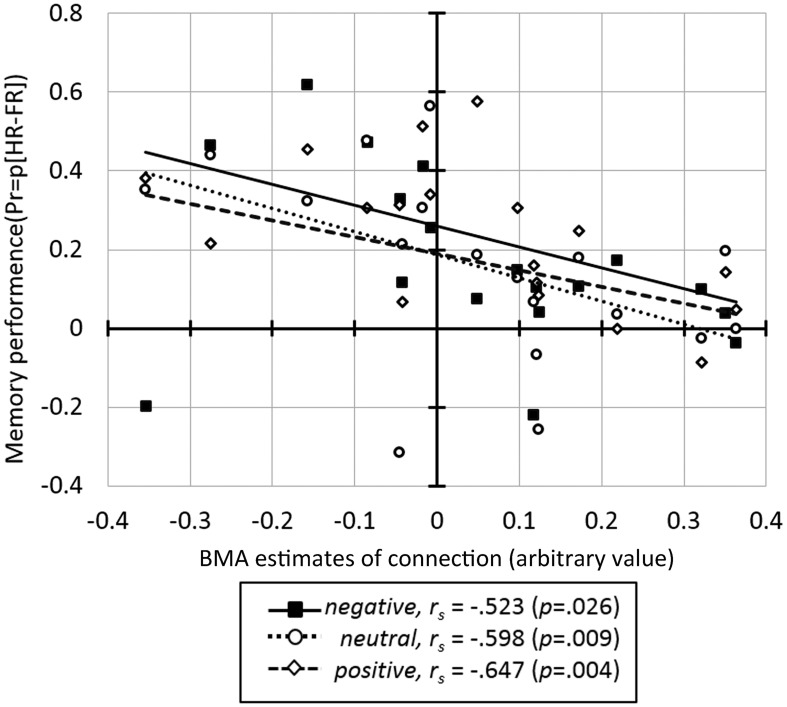
The correlation between the BMA parameter estimates for the IOG→OFC connection and memory performance for faces in three emotional expressions.